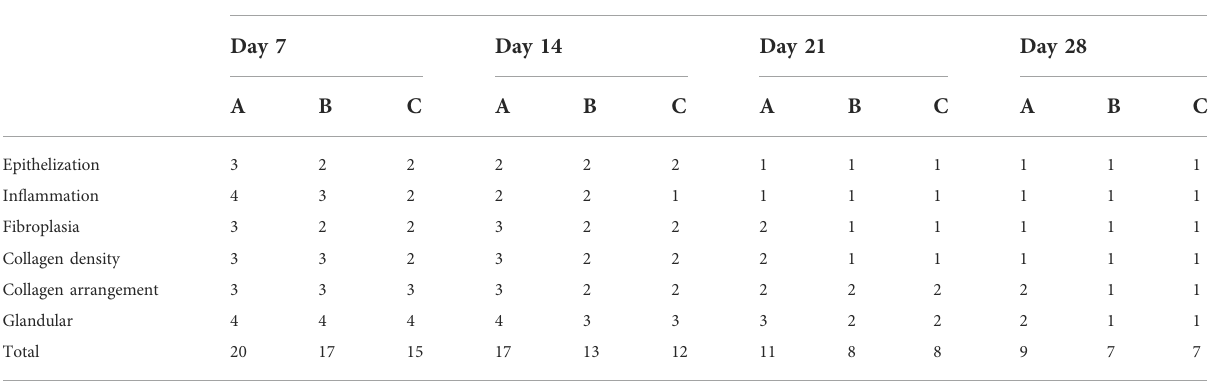
TABLE 2 Histological scores of wounded tissues in Groups A, B, and C at Days 7, 14, 21, and